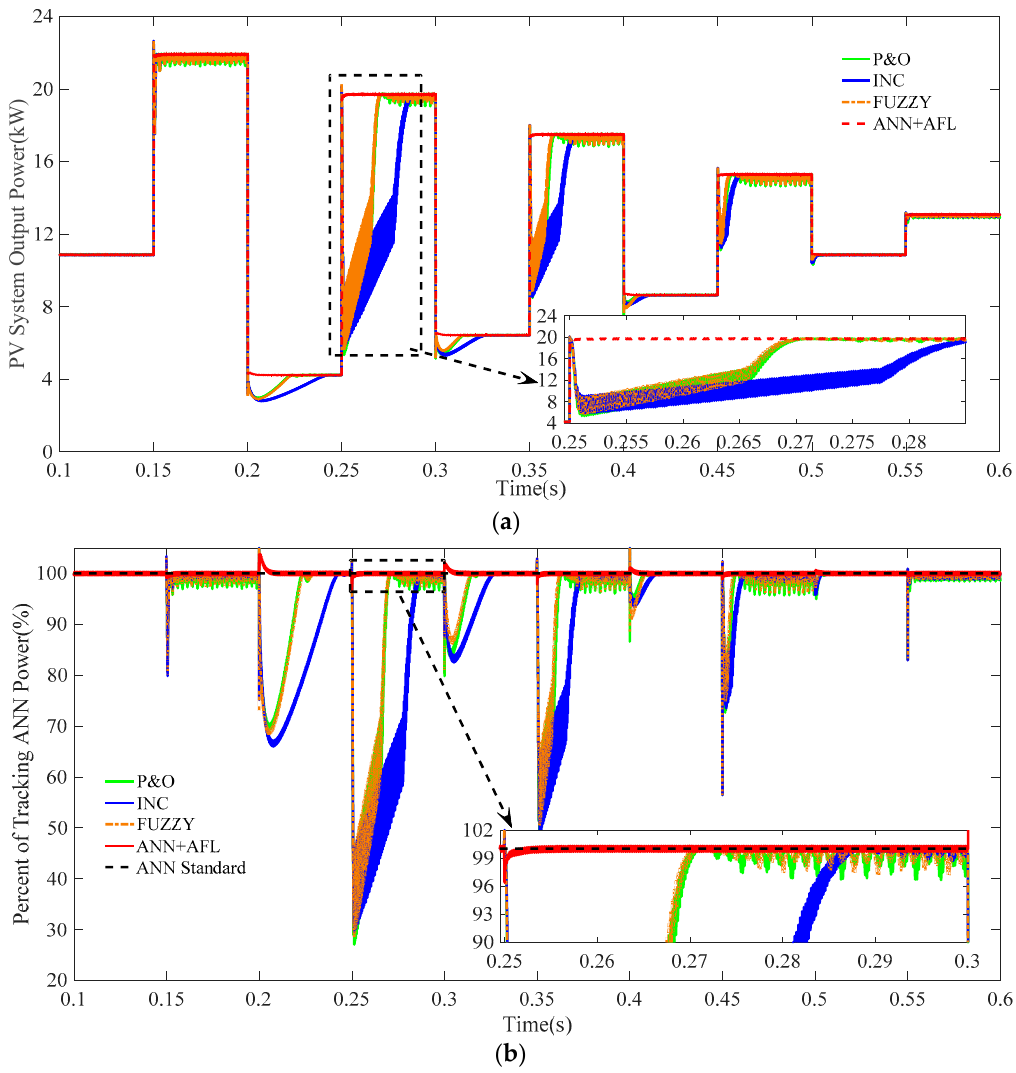
Figure 18. Output powers of the PV system with P&O, INC, fuzzy, and ANN + AFL methods: ( a ) Output power (overall); ( b ) Output power (detailed).